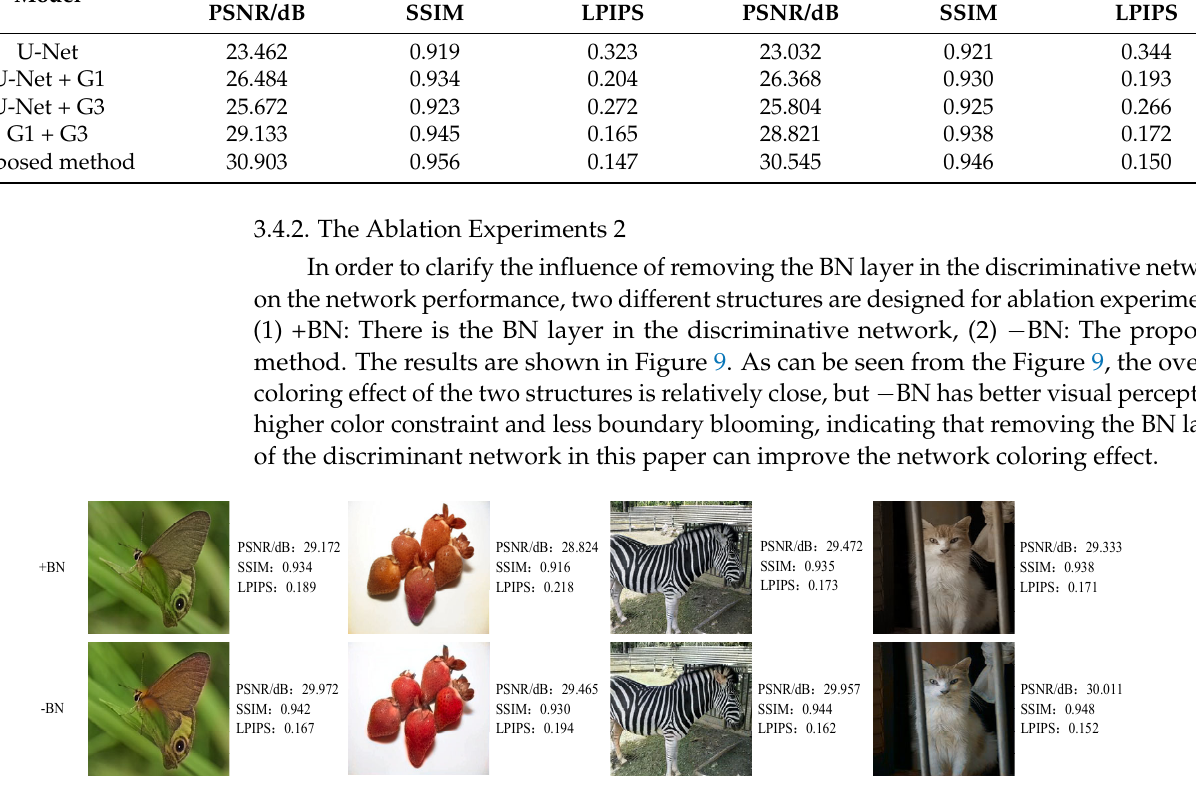
Figure 9. The results of the ablation experiment 2.